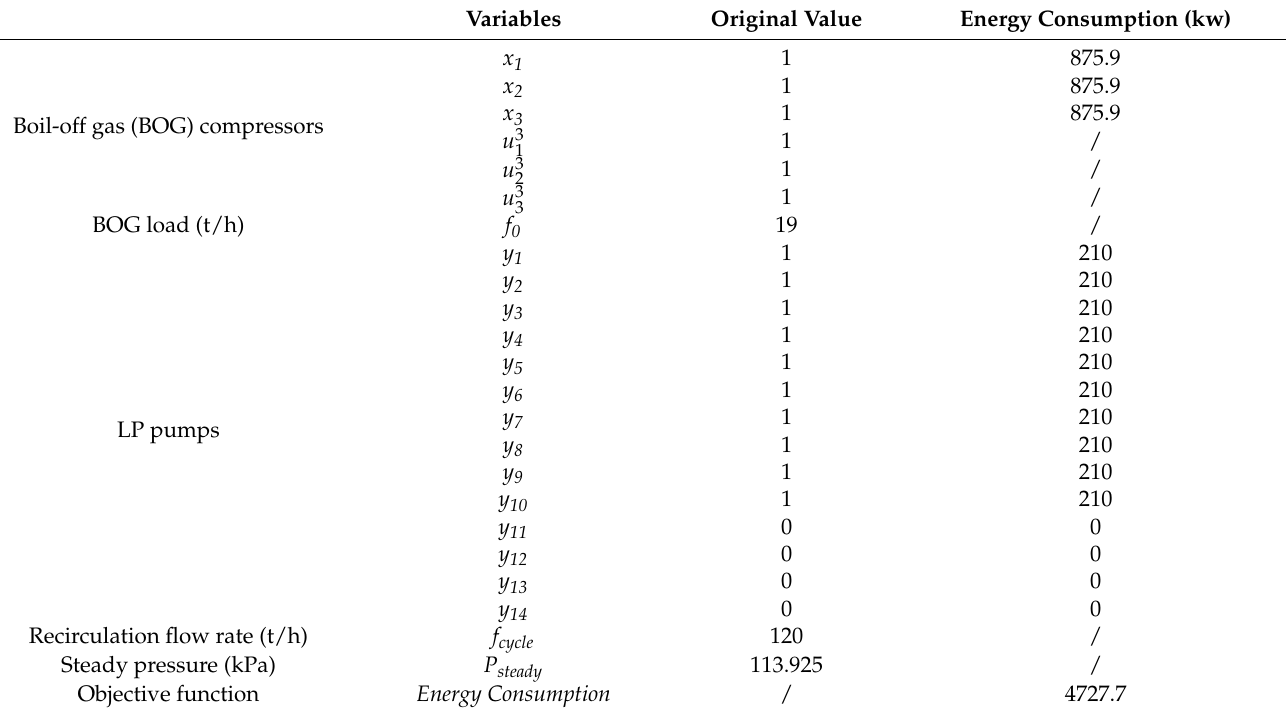
Table 6. Original operation condition of the LNG terminal.